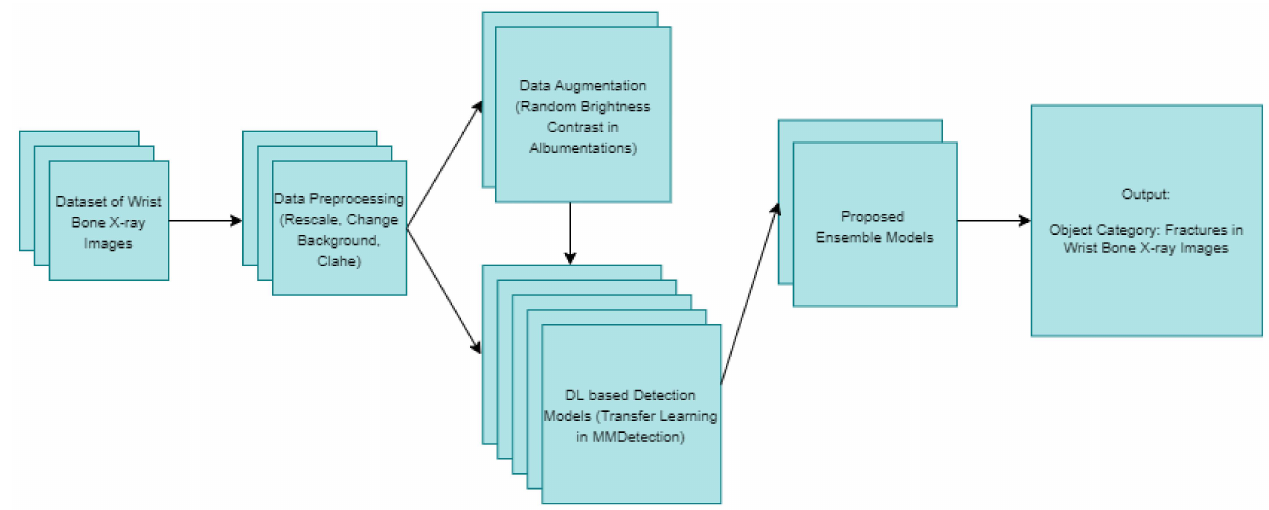
Figure 9. The proposed models for fracture detection of wrist X-ray